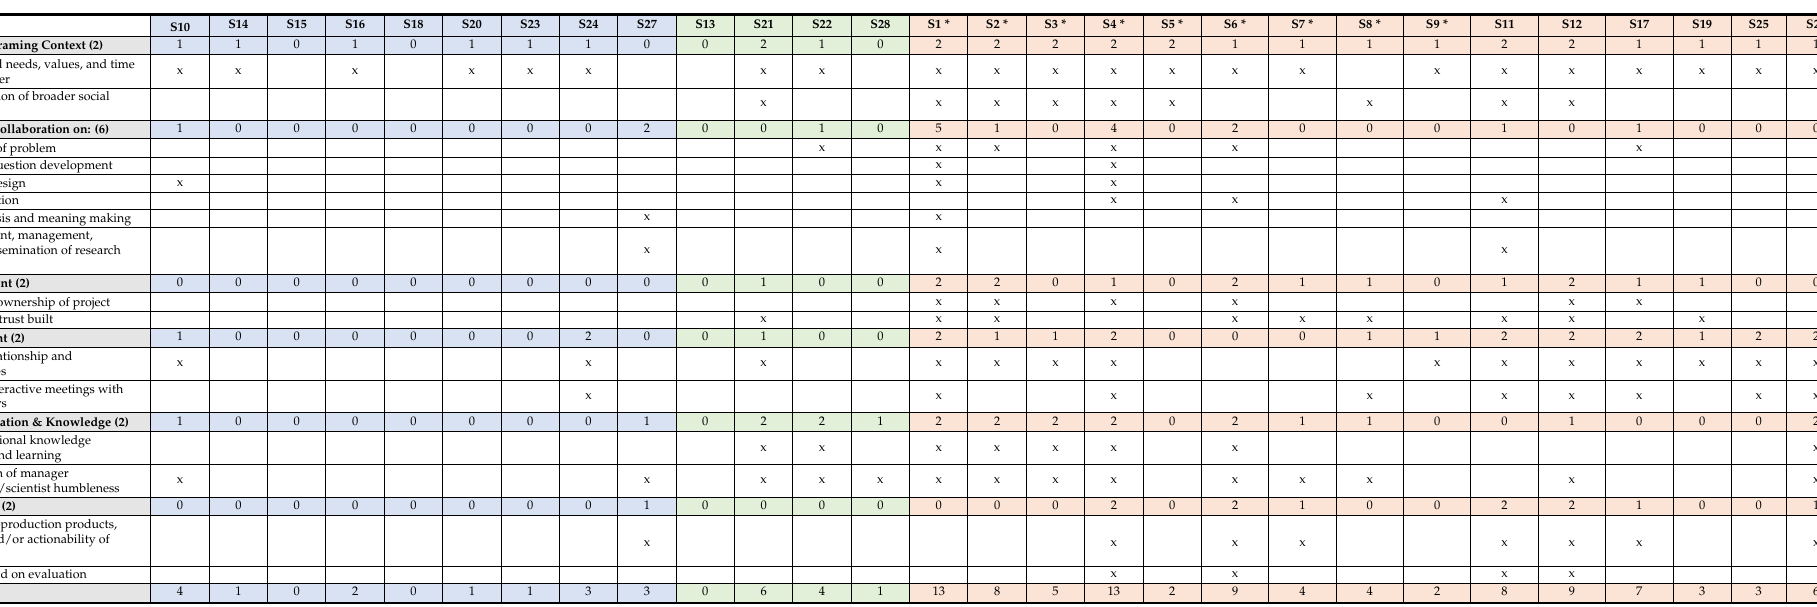
Table A1. Respondent participation in knowledge coproduction categories and activities. Colors indicate level of engagement (blue = L1, green = L2, salmon =